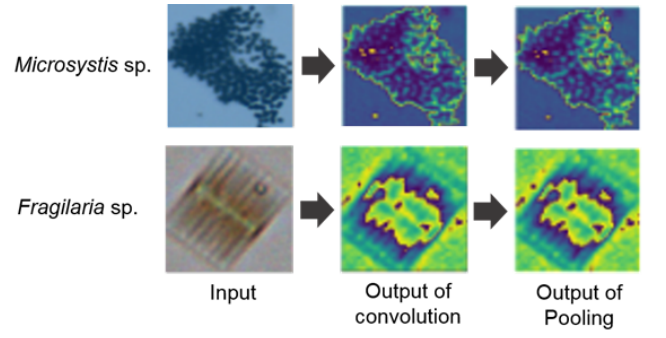
Figure 3. Examples of image outputs in the feature extraction